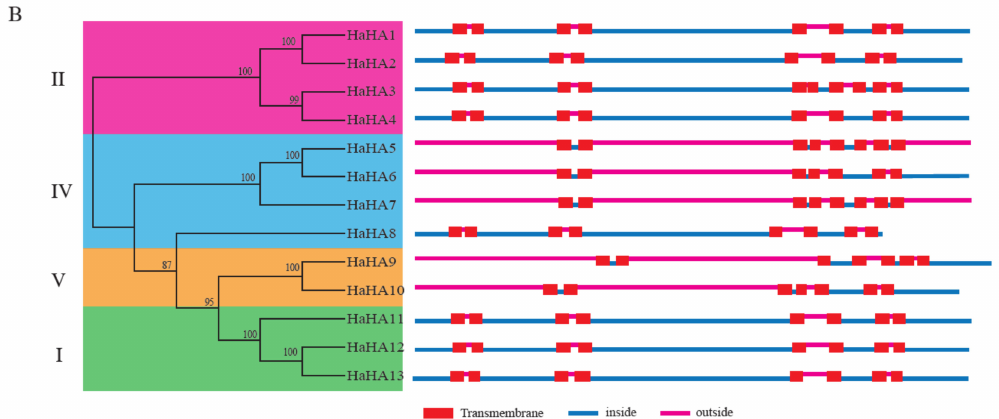
Figure 3. Multiple protein sequences alignment of HHA1–HHA13 ( A ) and the prediction of putative transmembrane domains ( B ). The multiple sequences alignment was analyzed with BioEdit software. High consensus amino acids are indicated with black, while low consensus residues are in gray. The pink boxes marked the typical conserved amino acid sequence of A-domain (TGE), P-domain (DKTGTLT), N-domain (KGAP), and the R-domain. The yellow boxes indicated the putative transmembrane domains (M1–M8). In panel B, the red rectangle represents the transmembrane region of the protein. The blue line represents the inner membrane area of the protein. The pink lines represent the outer membrane area of the